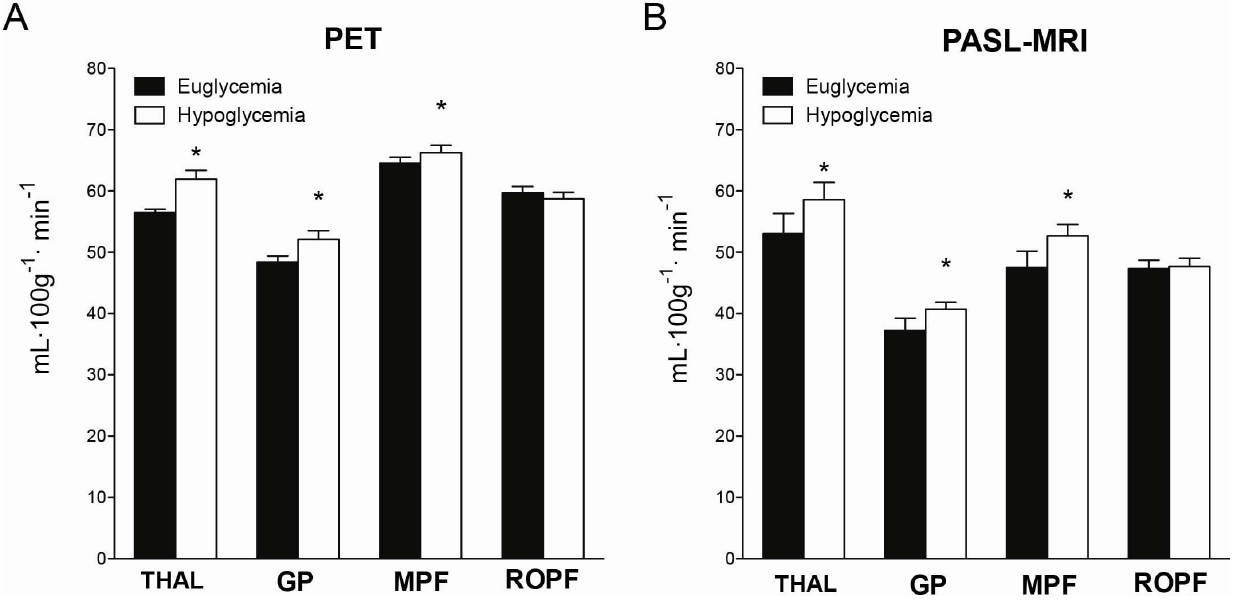
Figure 3. Qualitative cerebral blood flow during hypoglycemia and euglycemia in PET and PASL-MRI. Axial images showing the mean difference (CBF hypoglycemia – CBF euglycemia) maps from nine subjects for A) positron emission tomography (PET) and B) pulse arterial spin labeling magnetic resonance imaging (PASL-MRI). Yellow/orange represents increased and blue represents decreased blood flow during the hypoglycemic relative to euglycemic session. Similar increases in CBF for hypoglycemia were seen for both methods within the thalamus.